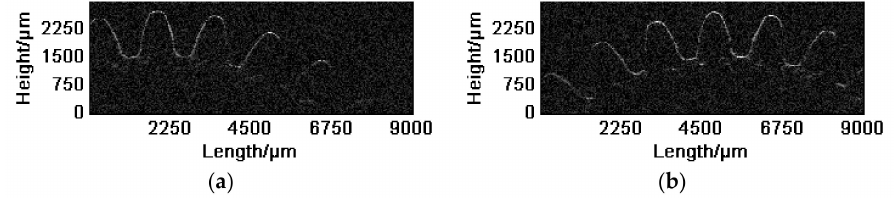
Figure 2. Measurement of different tooth profile with different angles of incident light: ( a ) imaging of an initial position of the gear; ( b ) imaging the gear with a rotation angle of 60 ◦ .